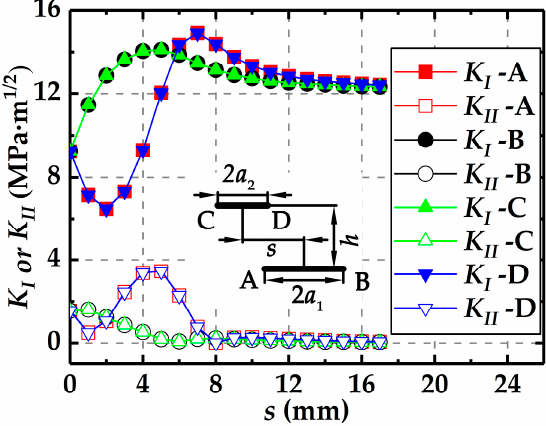
Figure 3. Changes of K I or K II with s at h = 2.5 mm for R a = 1.0.